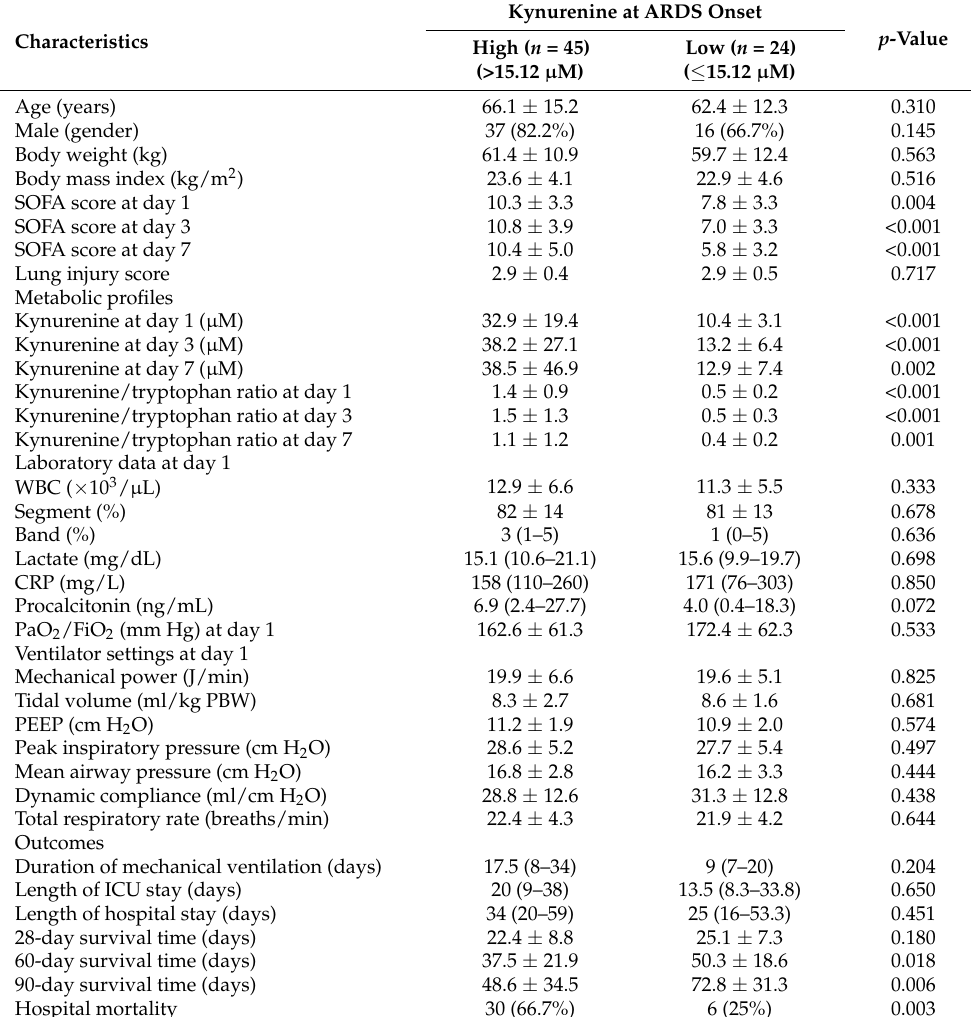
Table 2. The background characteristics, clinical variables, and outcomes as a function of plasma kynurenine at ARDS